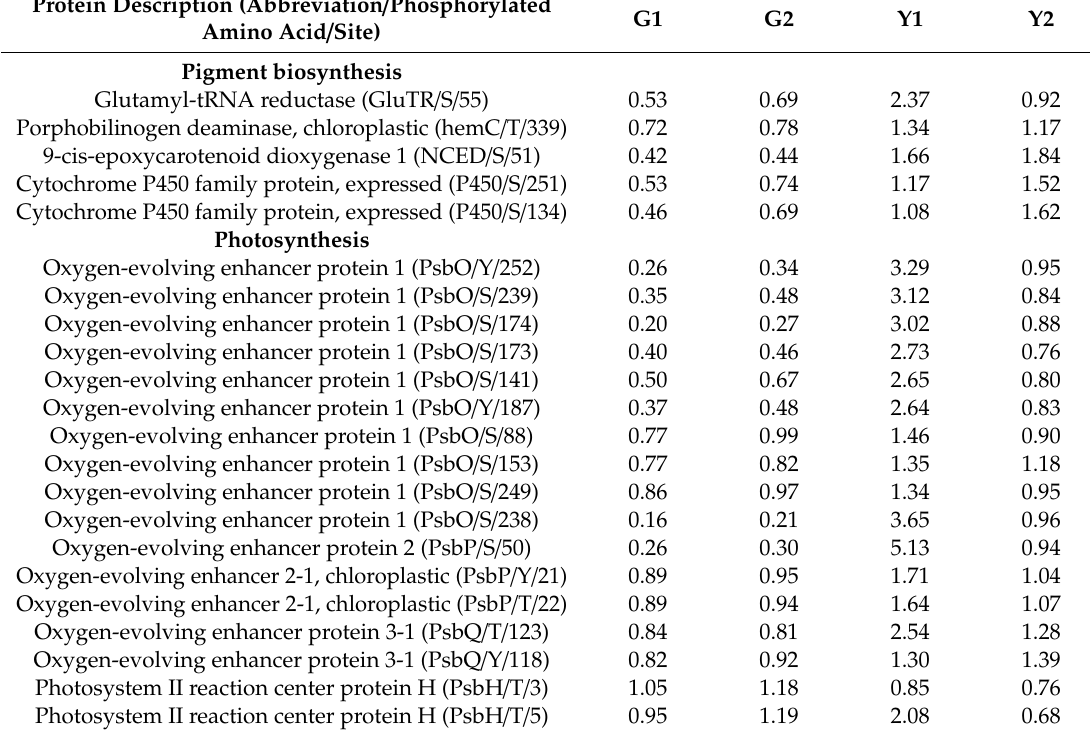
Table A1. The phosphorylation modification levels of the key proteins on the enriched pathways based on functional enrichment analysis in G1, G2, Y1 and